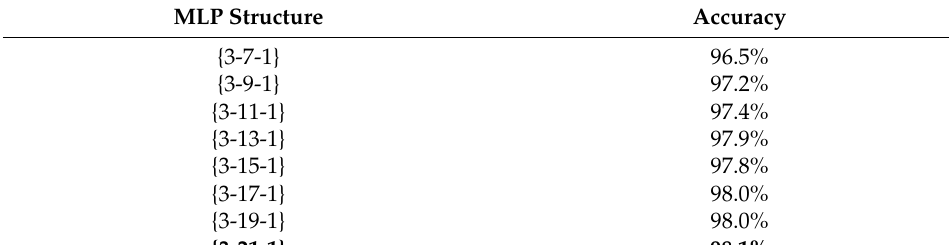
Table 1. MLP classifier accuracies for different structures of the network.